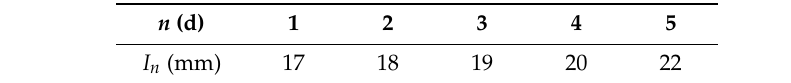
Table 4. The infiltration amount of continuous n -days precipitation in the Luanhe River Basin. n (d) 1 2 3 4 5 I n (mm) 17